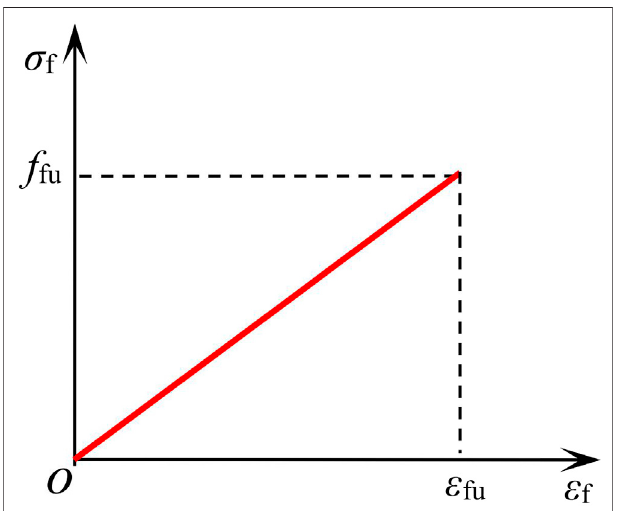
FIGURE 4 | Constitutive model of